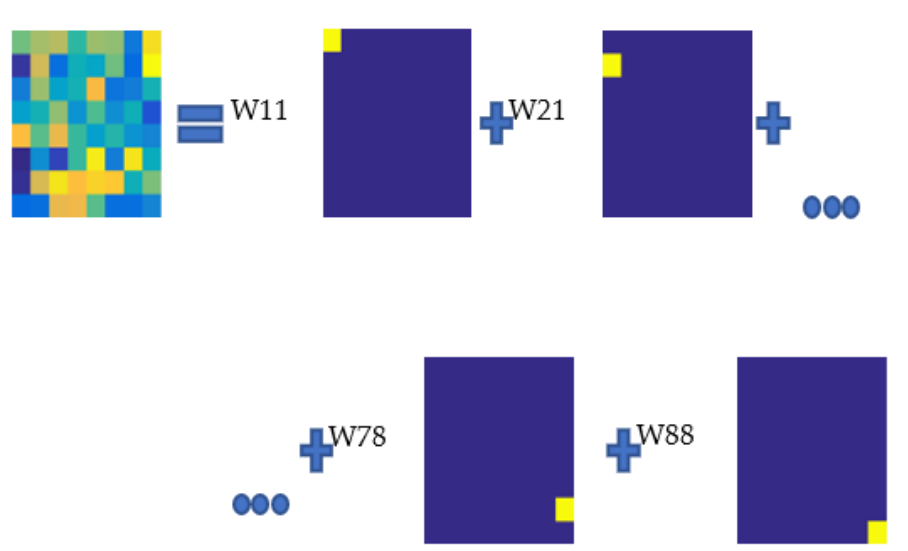
Figure 8. Visualisation of algebraic interpretation of the uncompressed image.